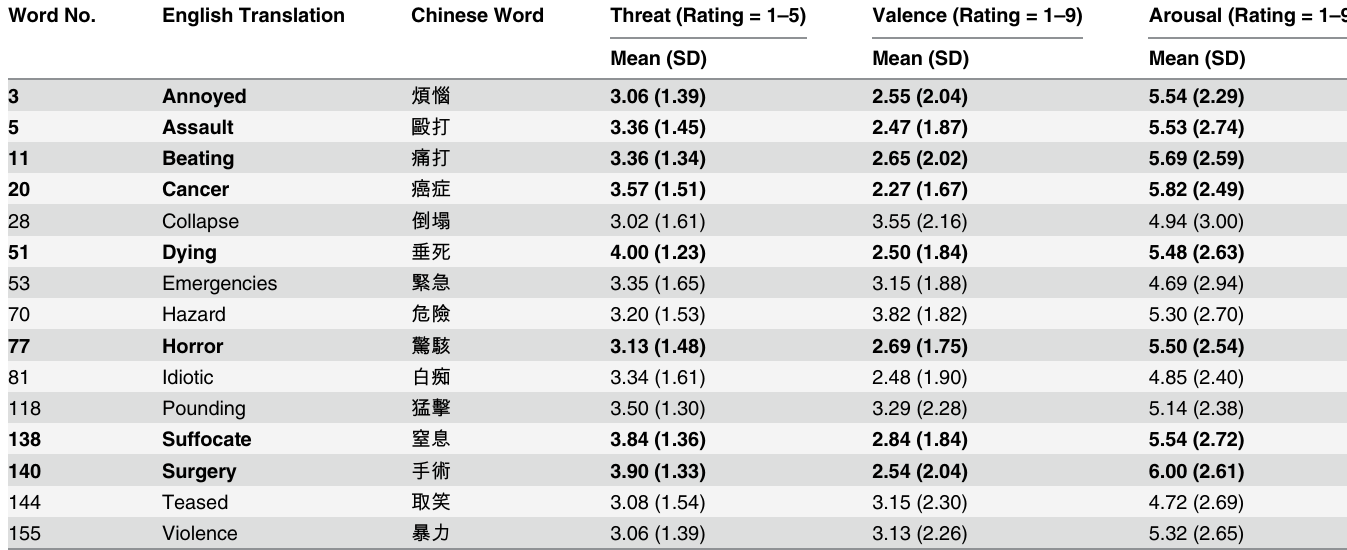
Table 1. Words with High Threat